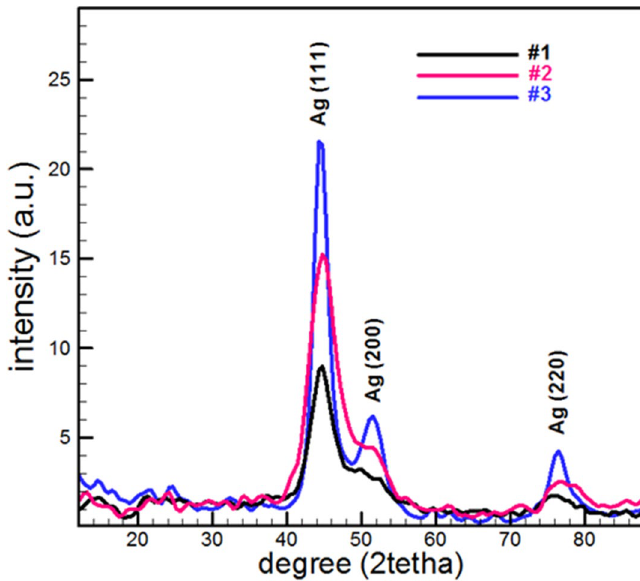
Figure 3. Typical XRD patterns of prepared Ag–DLC